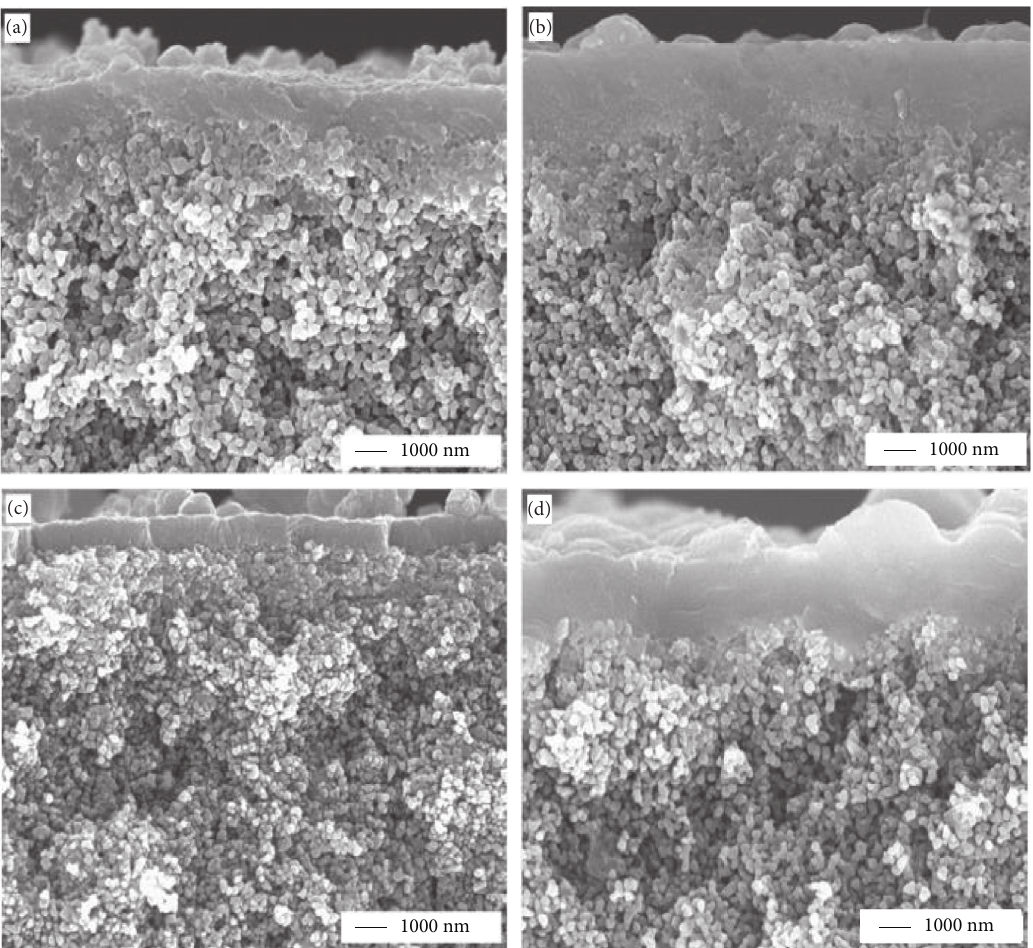
Figure 5: Side-view SEM images of membranes synthesized for 6 and 9 hours in one step (a and c) and 2 and 3 steps (b and d) at 75 ° C adopted from Magdalena